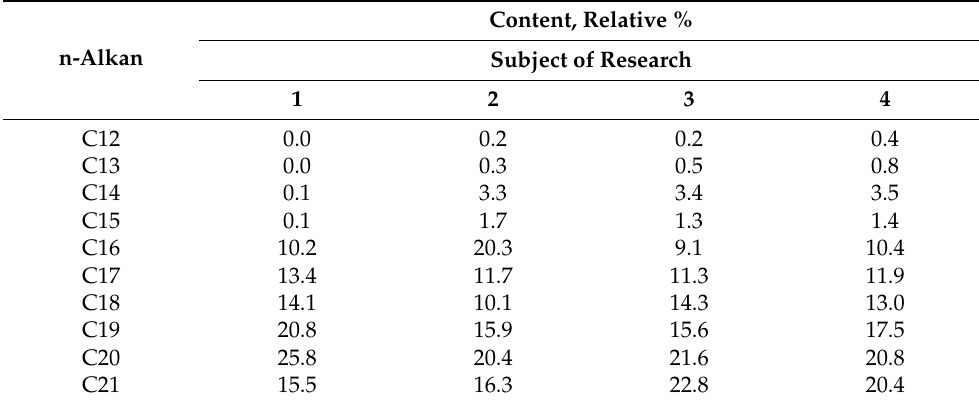
Table 7. Calculated values of the distribution of homologs of